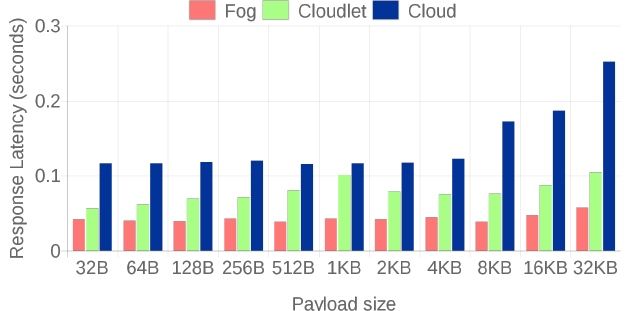
Figure 8. Response latencies for 32B to 32KB file